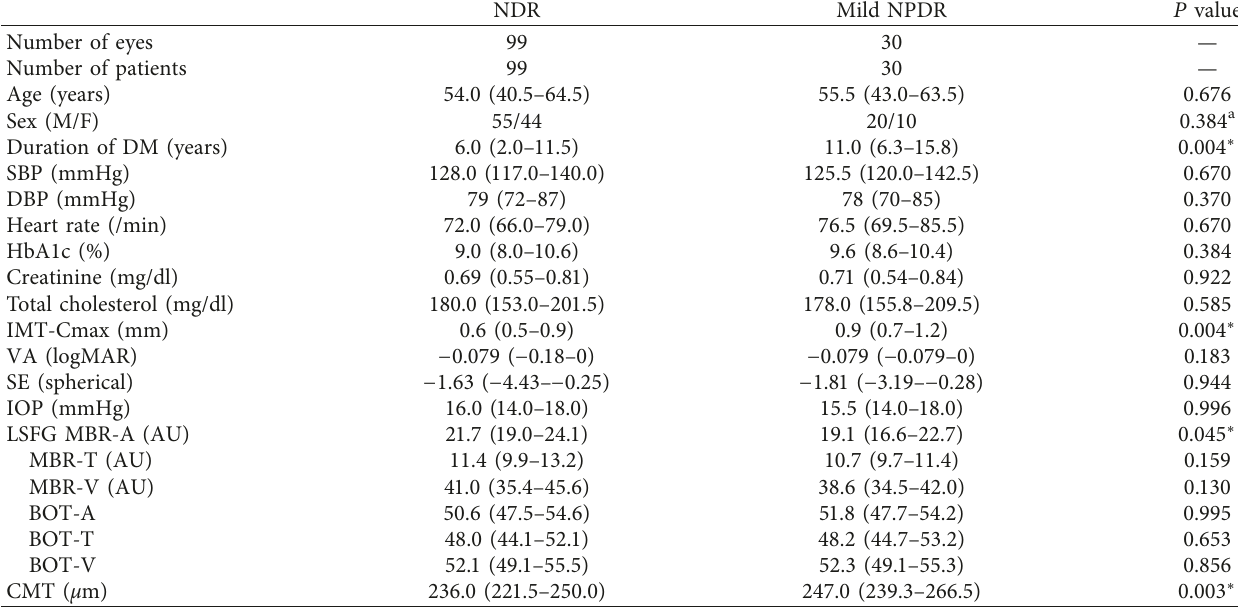
Table 1: Clinical characteristics of diabetes patients with NDR and mild NPDR.